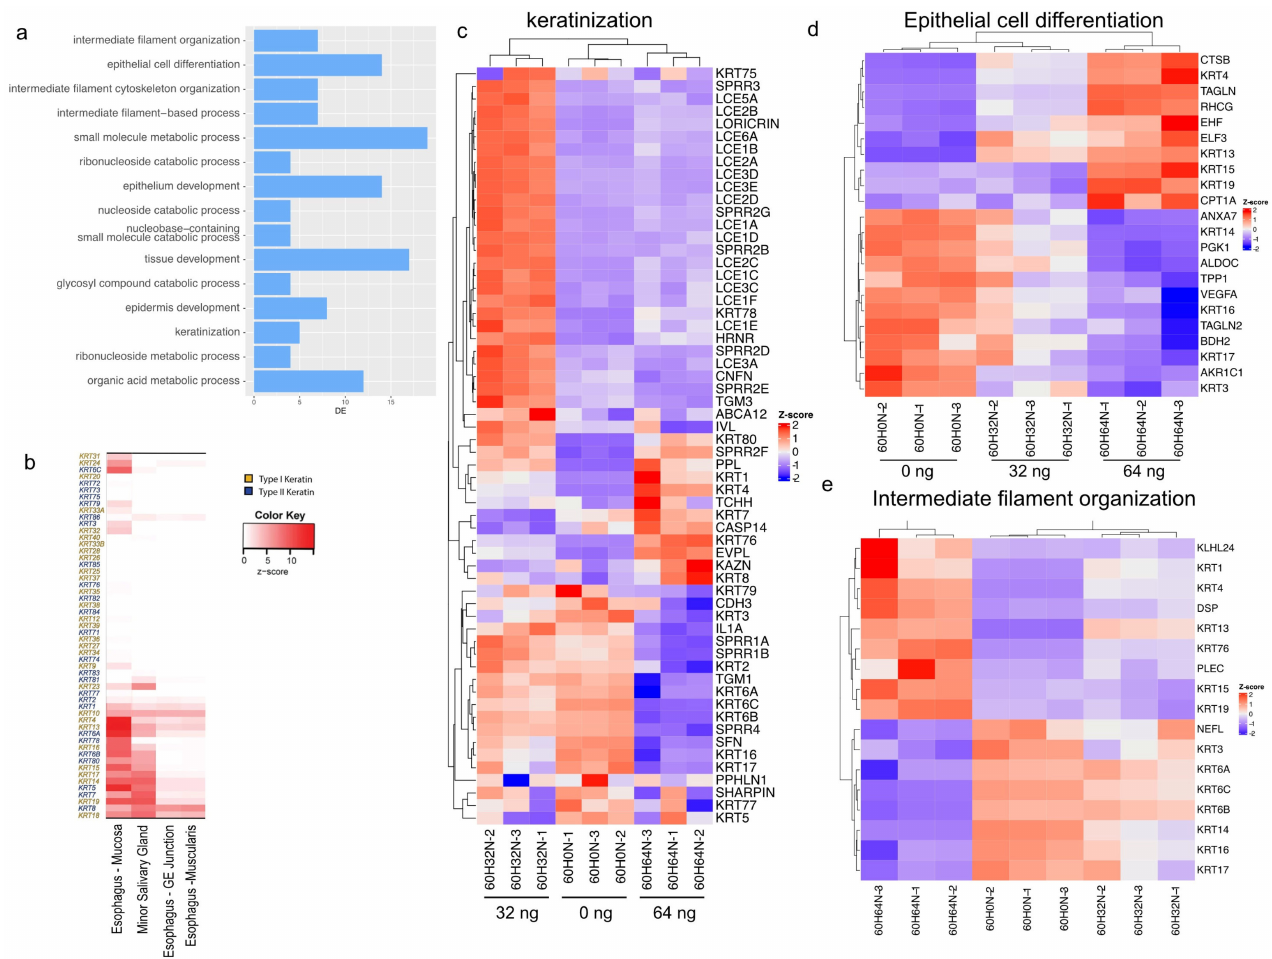
Figure 2. Effect of everolimus treatment on cell differentiation. ( a ) GO enrichment analysis for biological processes showing the fifteen most significantly changed pathways sorted according to sig- nificance ( y -axis). The number of differentially expressed genes is shown on the x -axis. ( b ) Selection of tissue-specific keratin expression in adult tissues (adapted from Ho et al., 2022 [13]). ( c ) Heatmap il- lustrating RNA-Seq differential expression data for genes associated with keratinization (GO:0031424). ( d ) Heatmap showing differential expression data for genes associated with epithelial cell differentia- tion (GO:0030855, padj < 0.01). ( e ) Heatmap showing the RNA-Seq results for genes associated with intermediate filament organization (GO:0045109, padj <